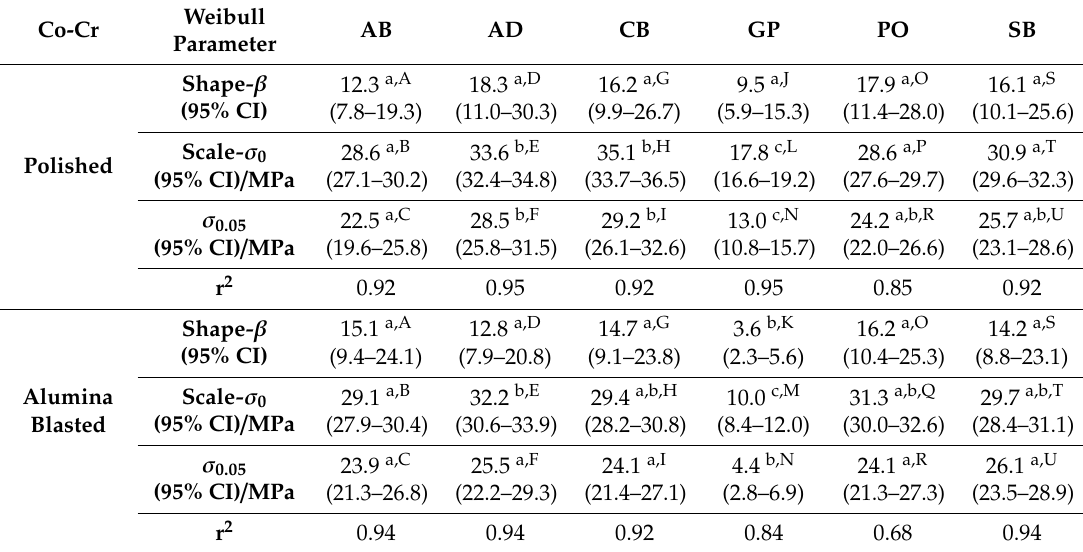
Table 3. The results of the Weibull analysis of the shear bond strength to Co-Cr specimens. Same lowercase superscript letters show values with no statistically significant di ff erence within each row, and same uppercase superscript letters show values with no statistically significant di ff erence for the same parameter within each column ( p > 0.05).